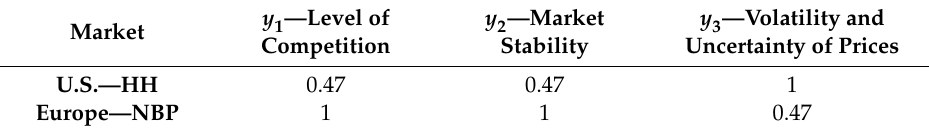
Table 10. Conditional entropy of each indicator.